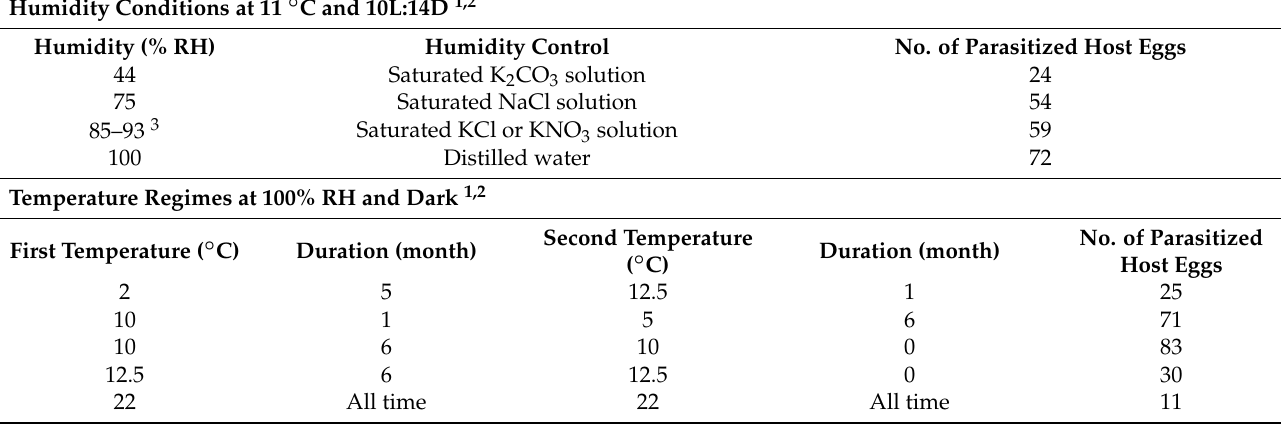
Table 1. Different humidity conditions and temperature regimes tested for diapause survival of A. fukutai larvae within parasitized A. chinensis